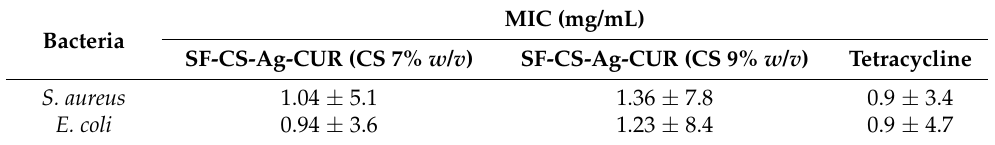
Table 5. MIC values of SF-CS-Ag-CUR (CS 7% w / v ) and SF-CS-Ag-CUR (CS 9% w / v ) nanofibers.